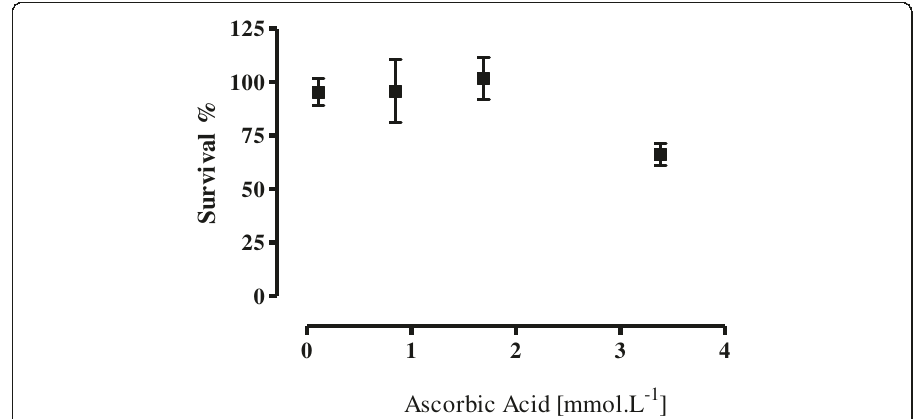
Fig. 7 Survival (%) ± SD of CA20948 as function of concentration of ascorbic acid in DMEM incubation medium containing 30 mmol.L -1 HEPES and 0.25 % BSA (total volume was 8.4 mL), n =